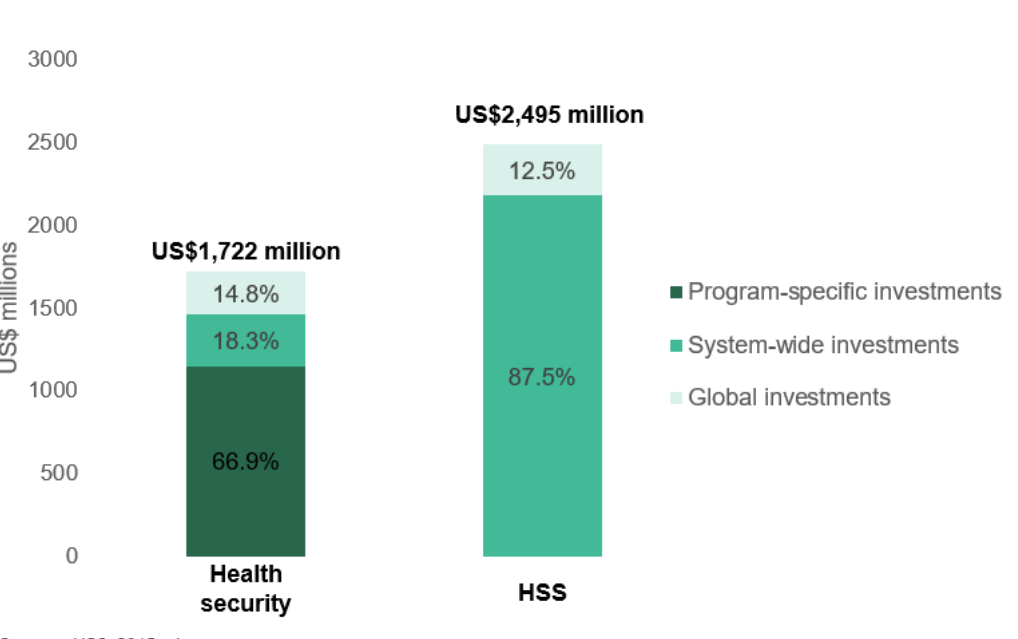
Figure 4. Distribution of system-wide health systems strengthening funding across major health system components. DAH, development assistance for health.